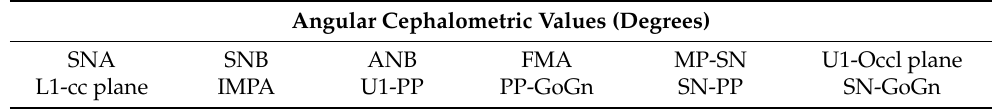
Table 2. Linear cephalometric values measured on the teleradiography of the skull in a lateral-lat- eral projection.